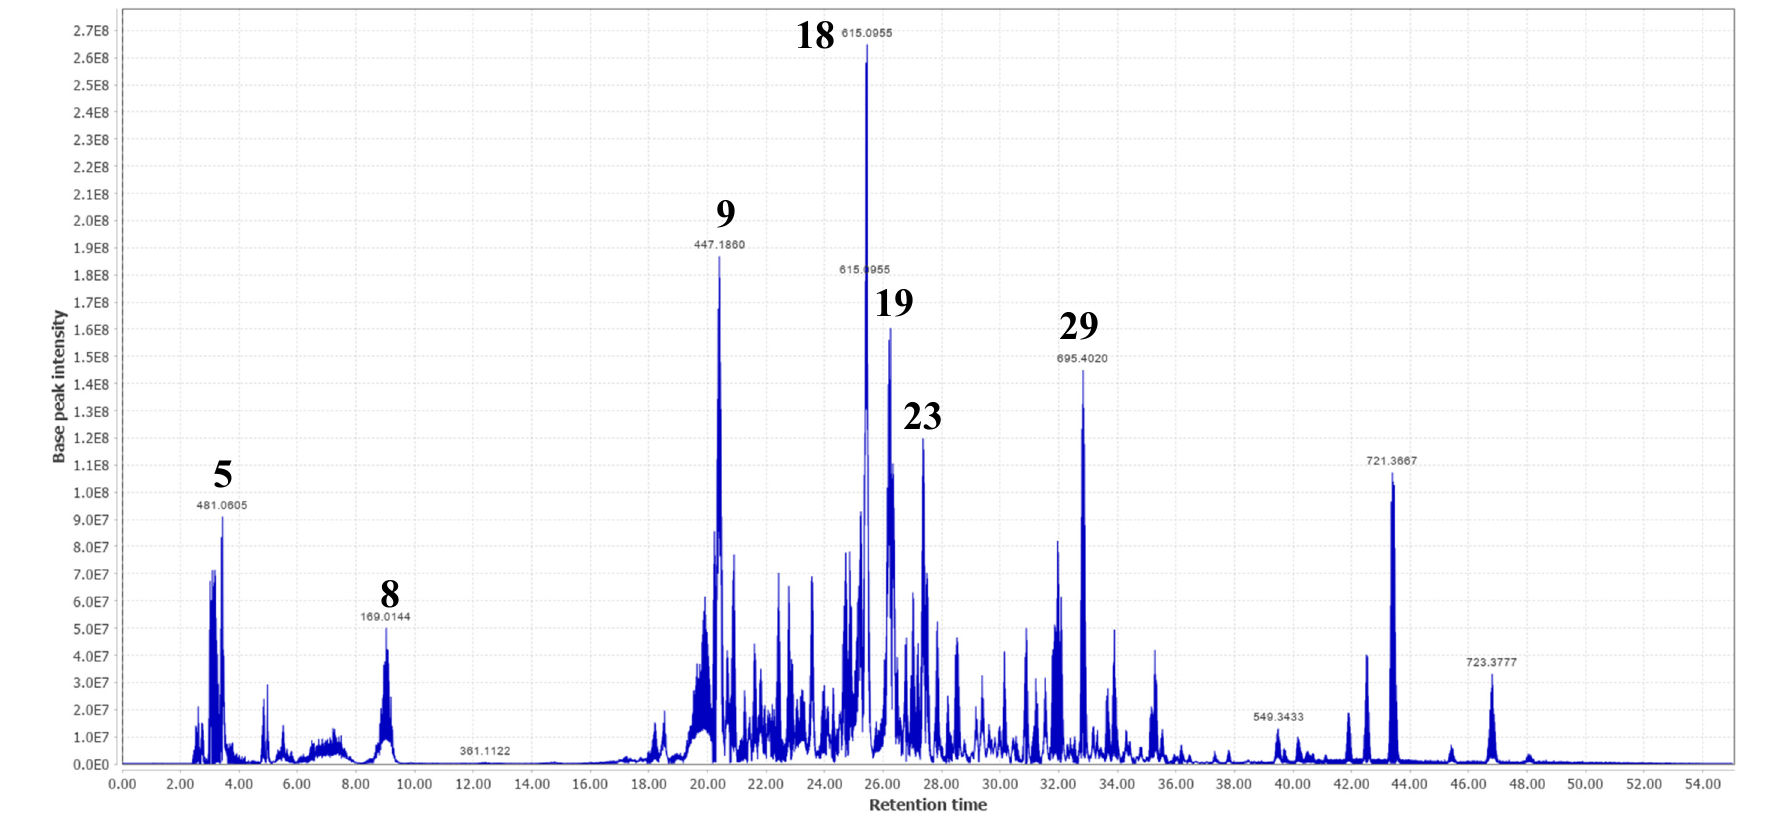
Figure 2. Base peak intensity (BPI) chromatogram of fraction 8 of the MeOH extract of Terminalia leiocarpa showing the main compounds identified. ( 5 ) 2,3-( S )- hexahydroxydiphenoyl-D-glucose or isomer; ( 8 ) gallic acid; ( 9 ) ellagic acid derivative; ( 18 ) quercetin-3- O -(6- O -galloyl)- β -D-galactopyranoside or isomer; ( 19 ) ellagic acid; ( 23 ) astragalin, and ( 29 ) rosamultin or isomer.